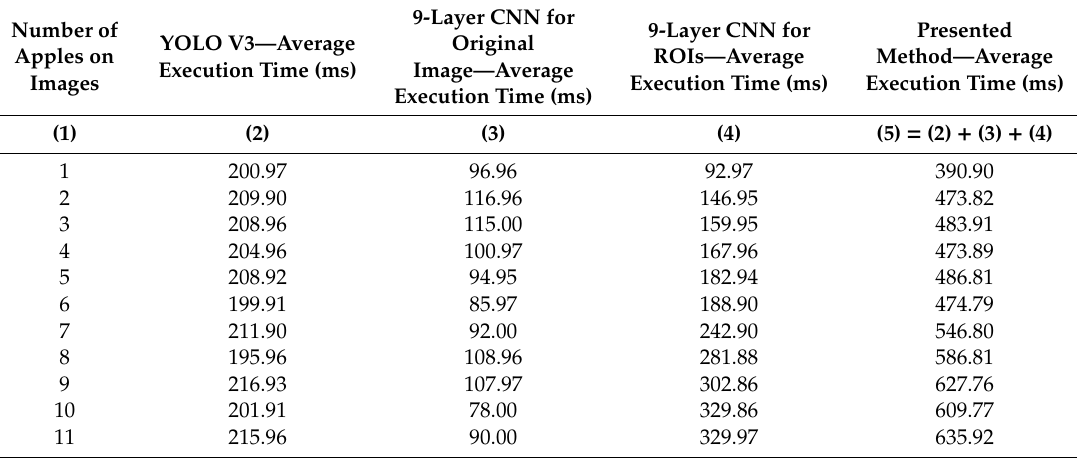
Table 9. Execution time analysis for the proposed method.